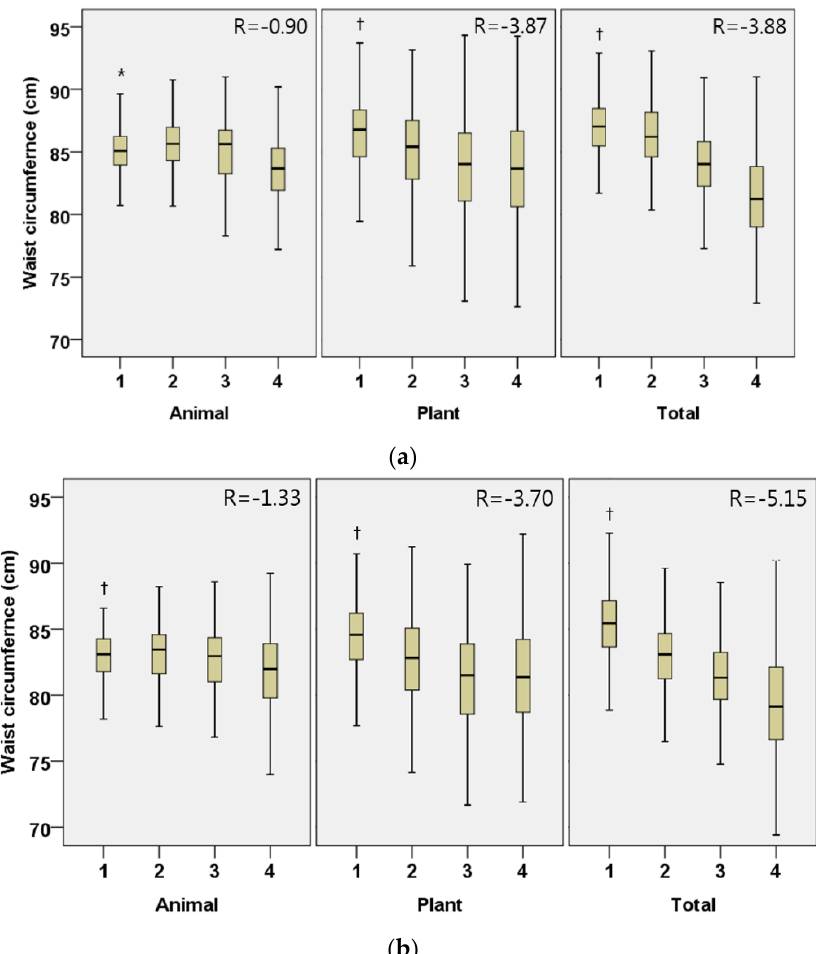
Figure 2. Adjusted waist circumference by the quartiles of daily animal, plant, and total protein intake per weight (g/kg/day) in Korean elderly population. ( a ) Male; ( b ) Female. All models are adjusted for age (year), household income quartile, education ( ≤9 years, 10-12 years, 13 ≤ years), presence of chronic disease (yes or no), current smoking status (yes or no), alcohol intake frequency per week (0, 1, 2 ≤) , physical activity (MET/week), % energy from fat (%), % energy from carbohydrate (%) and total energy intake (kcal). Participants were divided into quartiles for daily animal, plant, and total protein intake per weight (g/kg/day); male animal (Q1 < 0.13, Q2 0.13 – 0.29, Q3 0.30 – 0.56, Q4 0.56<), male plant